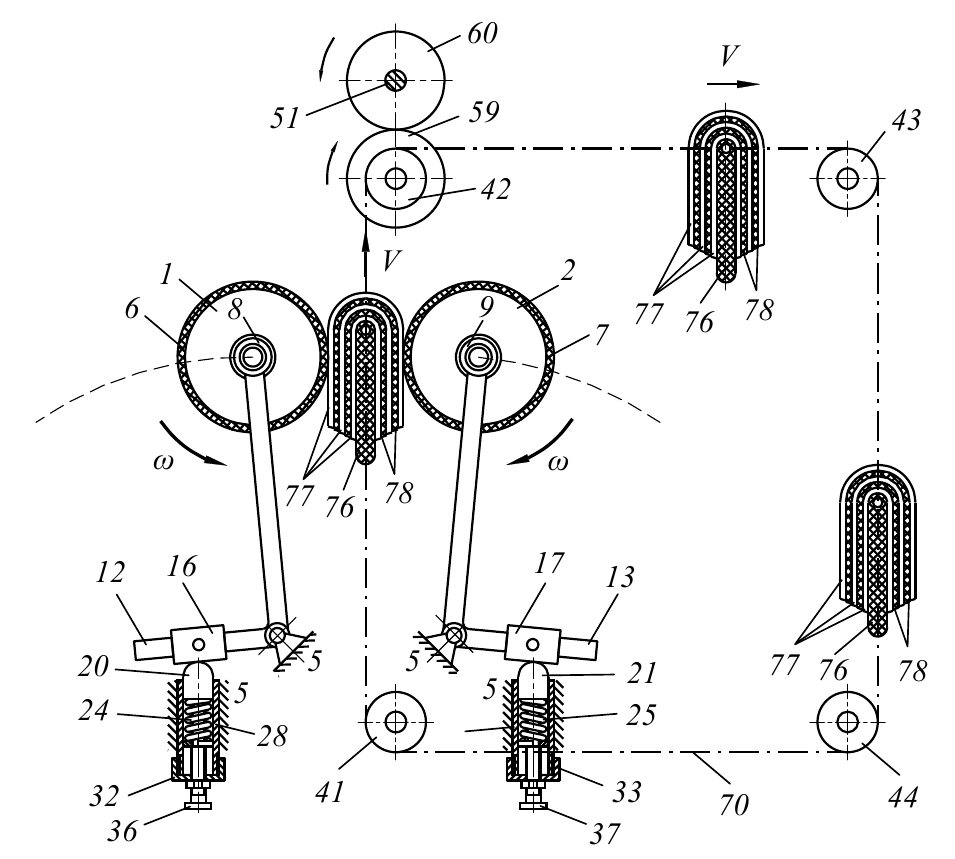
Figure 2. Scheme of motion of working bodies in contact with a package of processed leather semi-finished products.